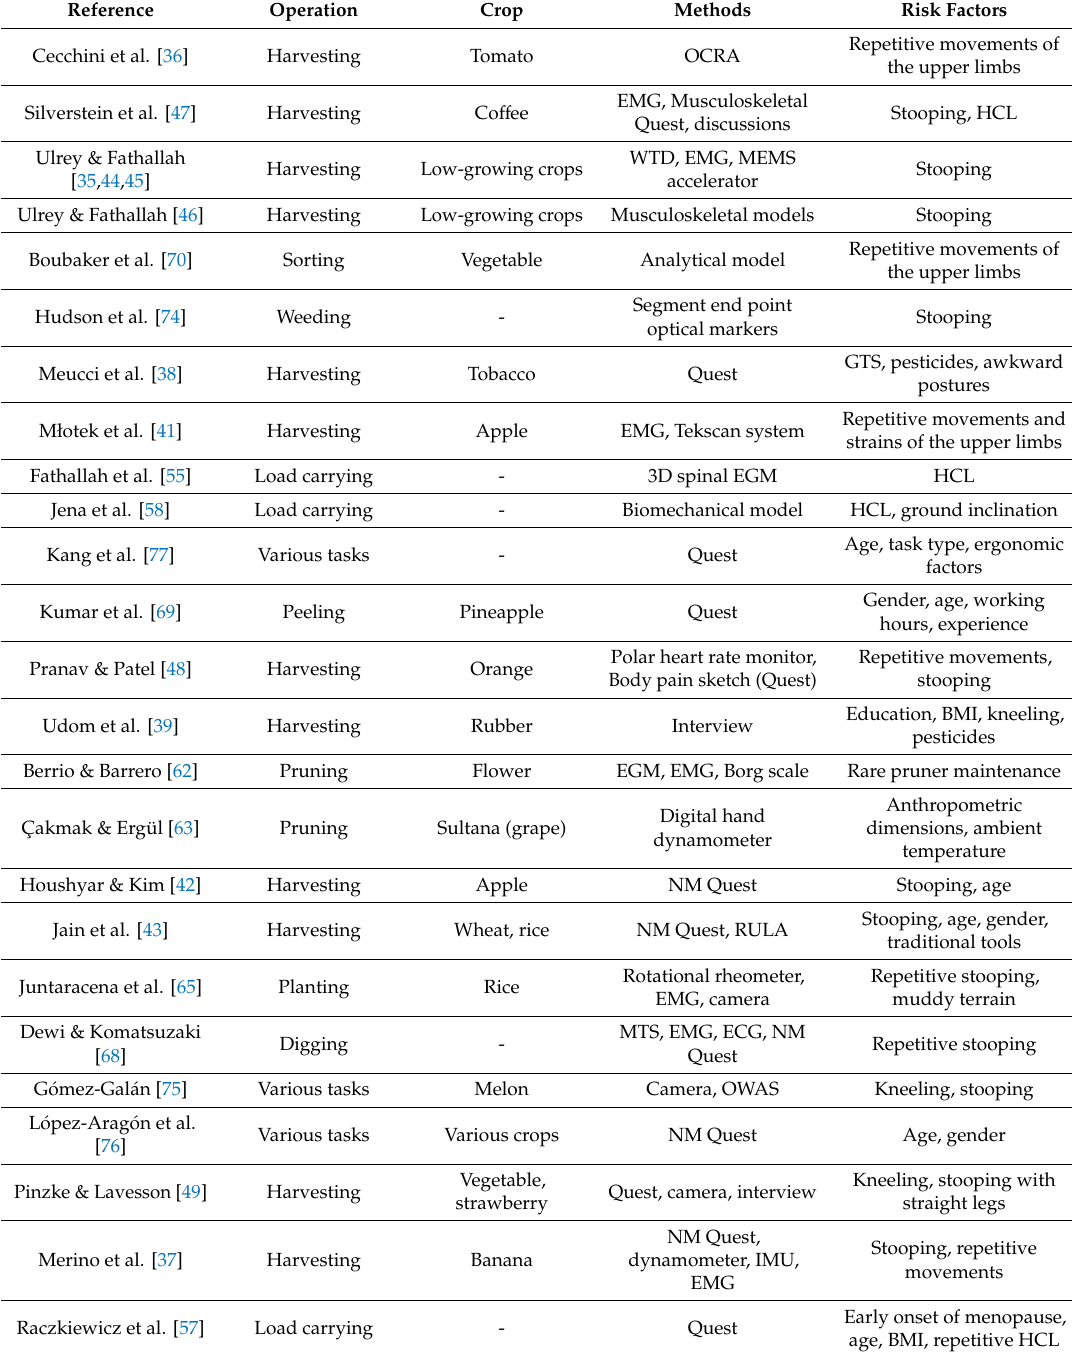
Table 1. List of journal papers dealing with MSDs as a result of occupation with agricultural manual